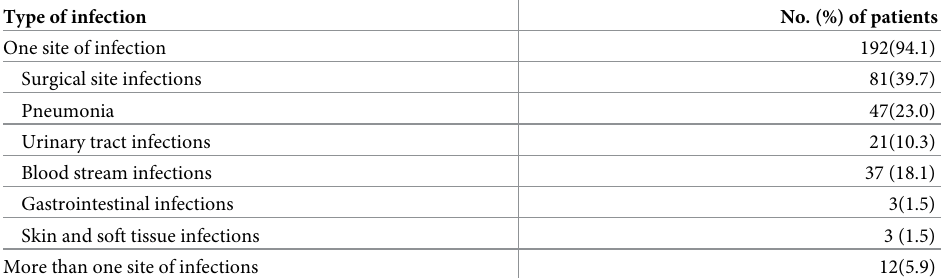
Table 2. Sites of healthcare-associated infections among patients at ACSH, Nov. 2019-Mar. 2020. Type of